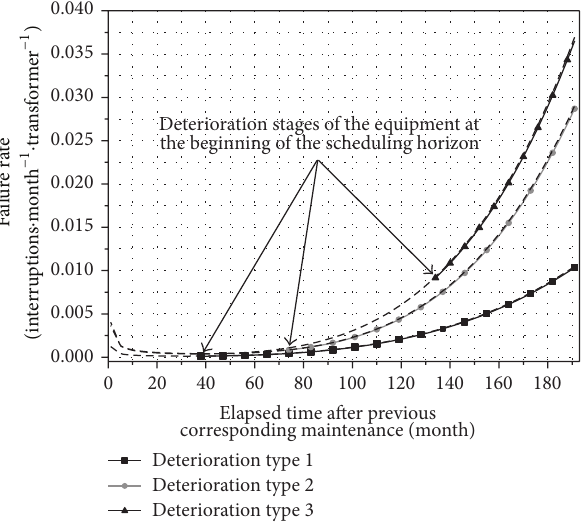
Figure 4: Reliability model of the transformer T13.